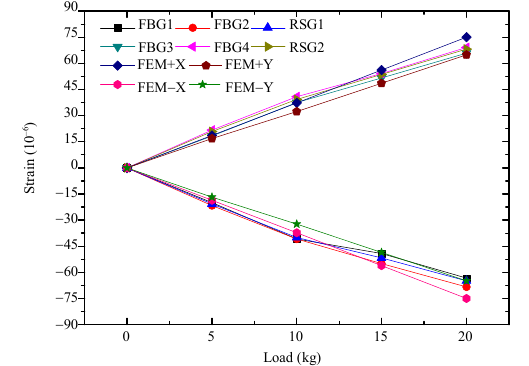
Fig. 7 Measured strain data by FBG sensors, resistance strain gages, and calculated from FEM analysis.